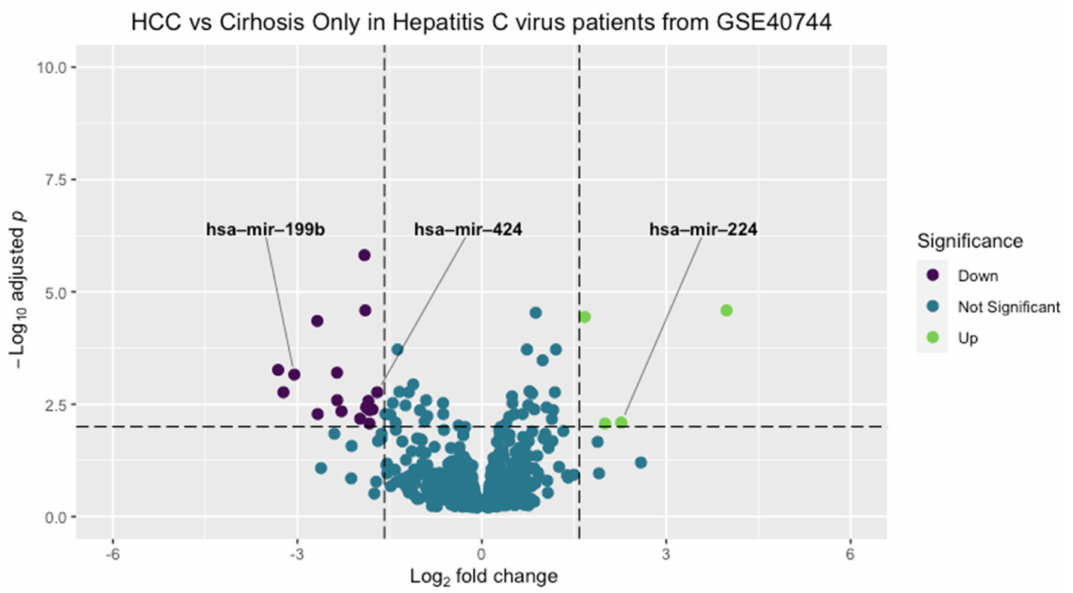
Figure 1. Volcano plot of microarray differentially expressed miRNAs. MiRNAs colored in purple were downregulated, and those colored in green were upregulated in HCC samples compared to cirrhotic HCV samples. The filtering criterion was adjusted using a log 2 fold change cutoff of 1.5 and an adjusted p -value cutoff of 0.01. (GEO: Gene expression omnibus, HCC: Hepatocellular